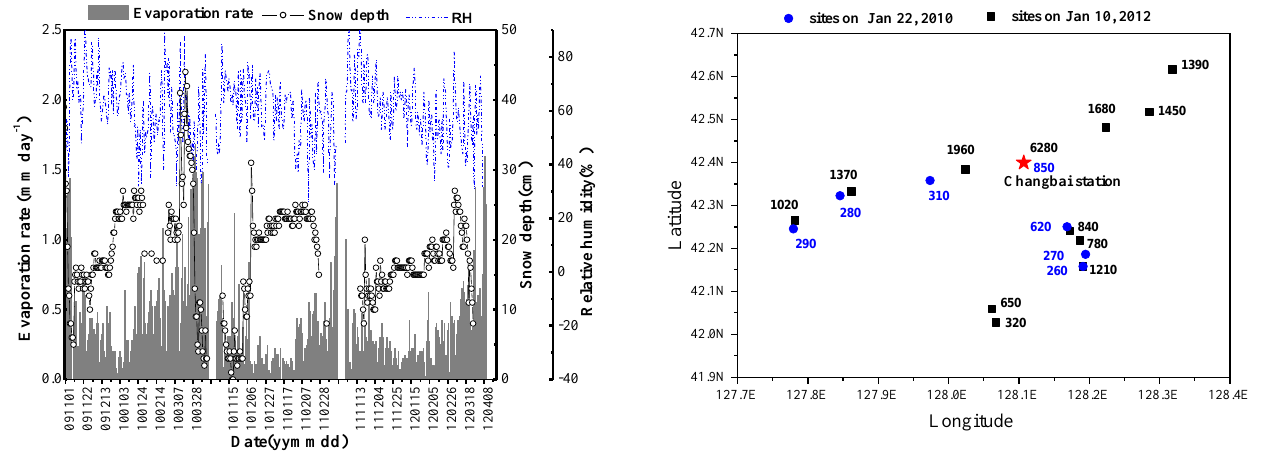
Fig. 3. Daily means of evaporation rate, snow depth, and relative humidity in winter 684